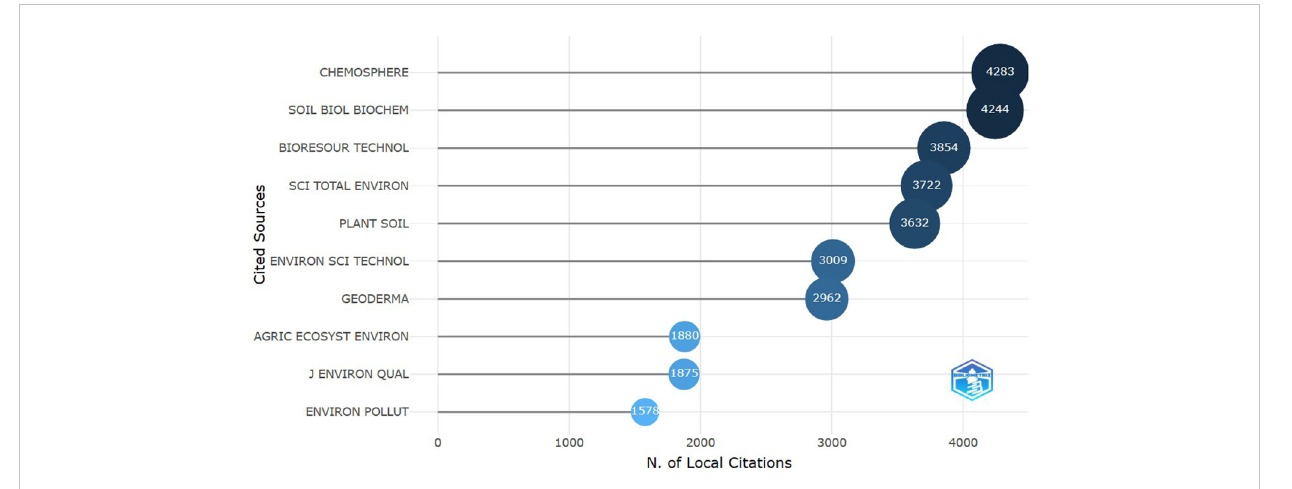
FIGURE 2 Top ten of most locally cited sources on biochar-based smart